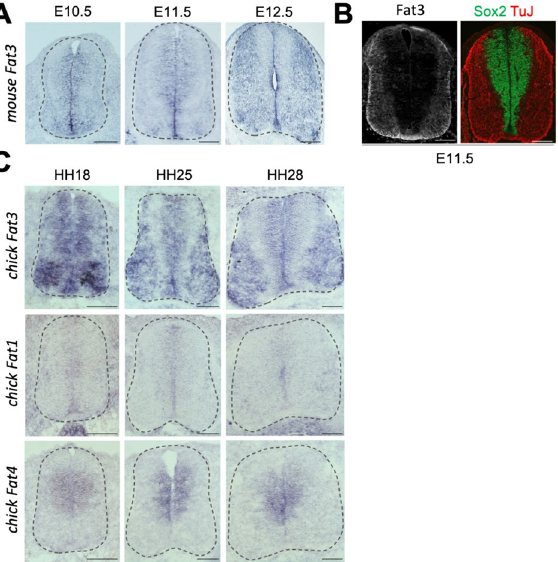
Figure 1. Expression of Fat cadherins in developing spinal cord. ( A ) Expression pattern of Fat3 in mouse embryonic spinal cord by ISH (cervical level). Fat3 is mainly expressed in the ventricular zone and then remained in the mantle zone (MZ) of spinal cord from E10.5–12.5. ( B ) Fat3 protein was detected in the MZ barely at E11.5 by immunohistochemistry (IHC). Sox2 staining shows the neural stem cells and TuJ staining represents differentiated neuronal area. ( C ) Expression patterns of Fat3, Fat1 and Fat4 in chick spinal cord by ISH . Dotted outlines indicate the border of the spinal cord. Scale bars: 100